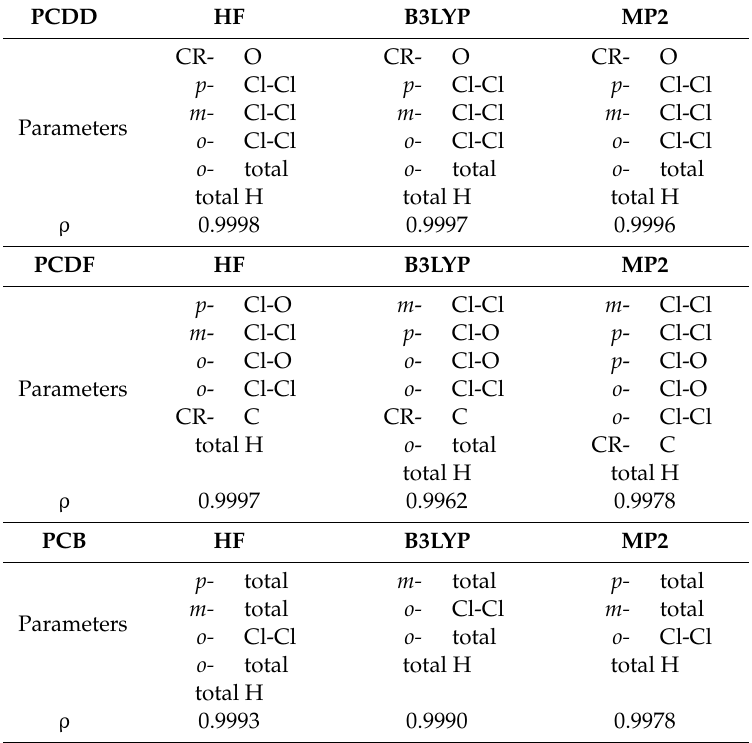
Table 2. Parameters (in order of x 0 , x 1 , x 2 , ... ) for relative stability prediction and the corresponding correlation coe ffi cients ( ρ